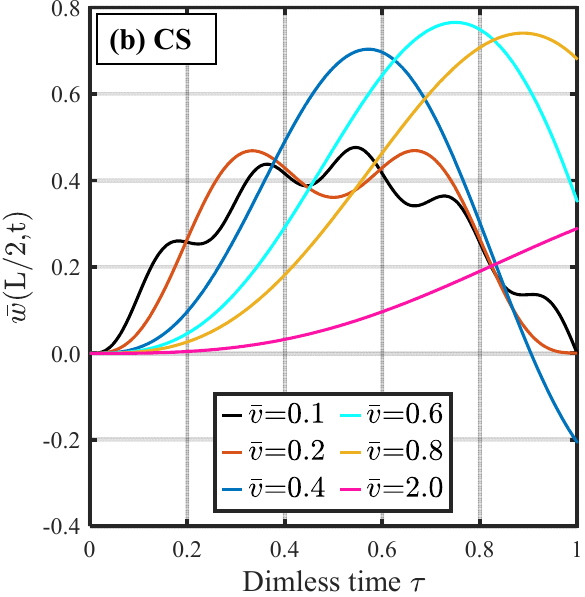
Figure 9. Influence of the dimensionless velocity on the variation in the dimensionless central deflection vs. the dimensionless time under a uniform moving load based on CL and CS formulations ( ∆ T = 80, LTR , k x = k z =